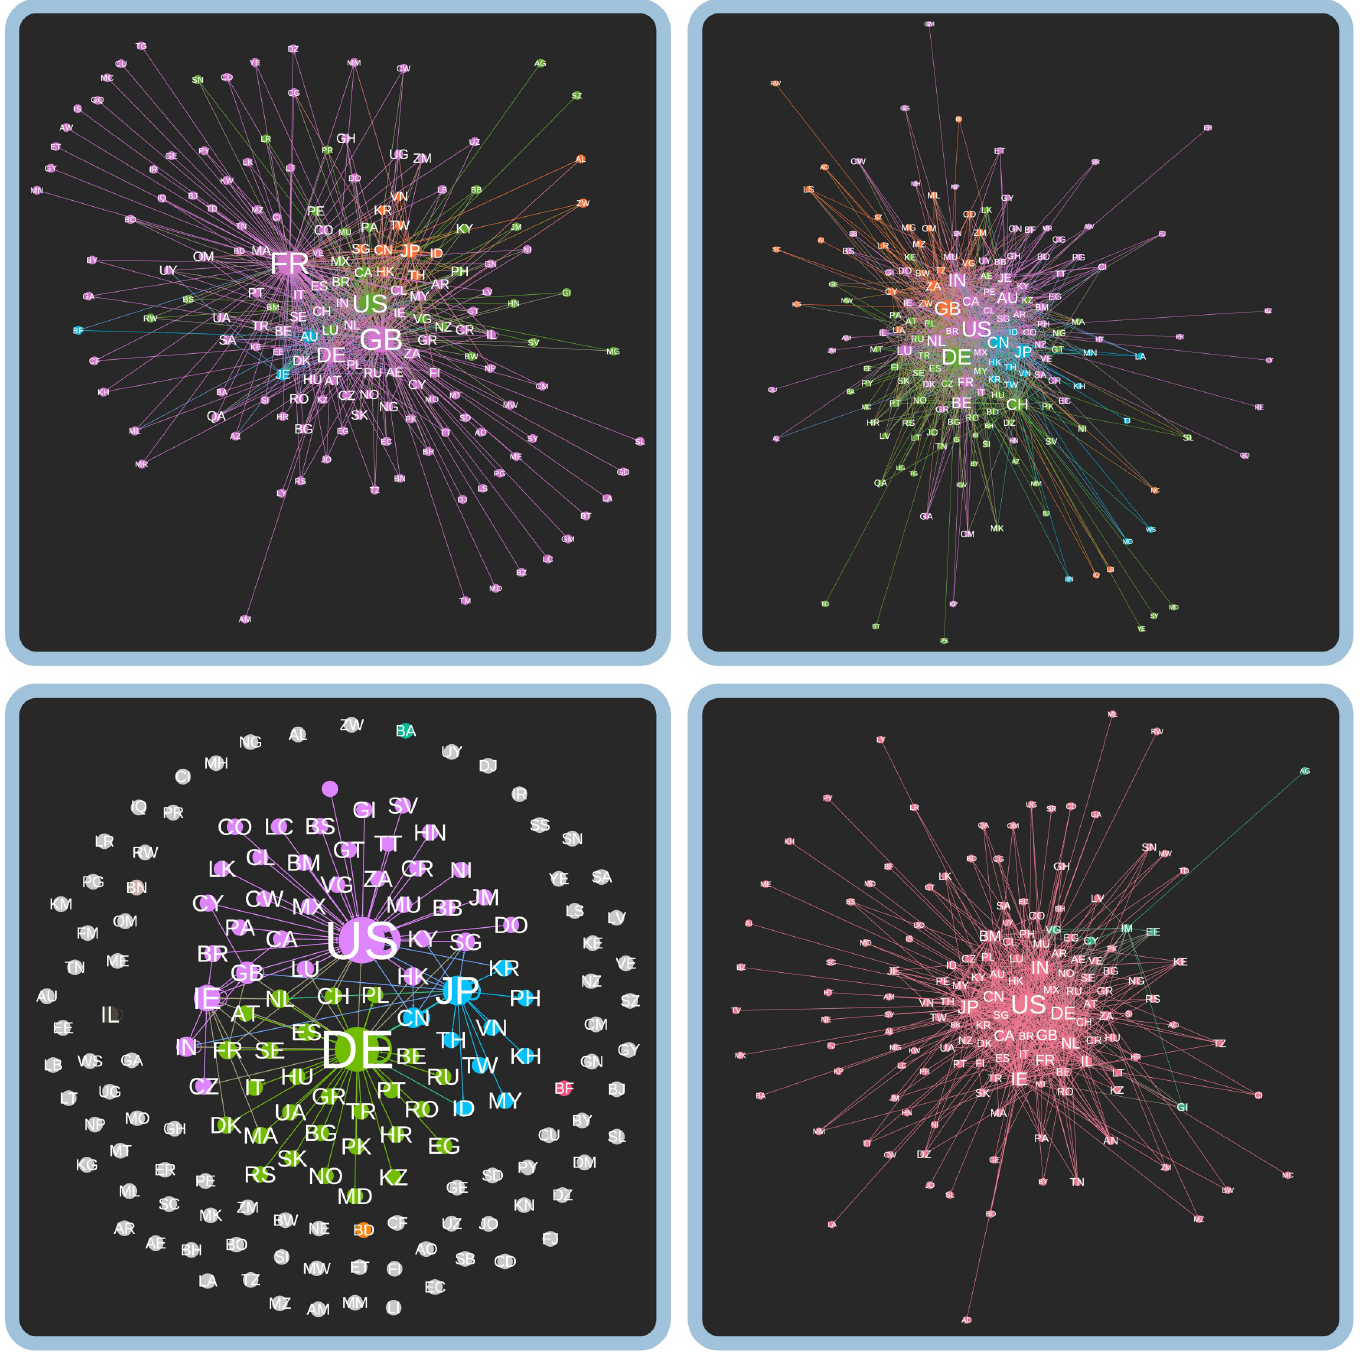
Fig 5. Networked industrial geographical structures of the global economy. Top-right: Technology Hardware & Equipment (clique-like), Top-left: Commercial & Professional Services (polycephalous), Bottom-left: Food & Staples Retailing (segmented-decentralised), Bottom-right: Real Estate (star-like). Colors indicate communities as partitioned by the Blondel algorithm [58], while the size of the nodes is proportional to their